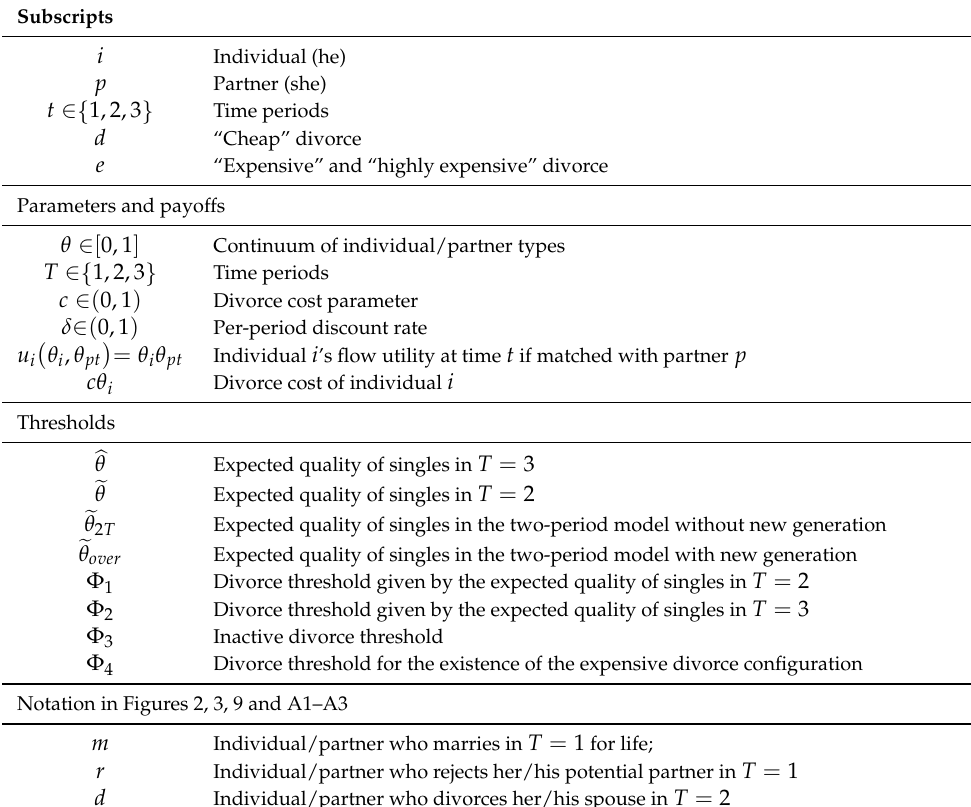
Table 1. Acronym